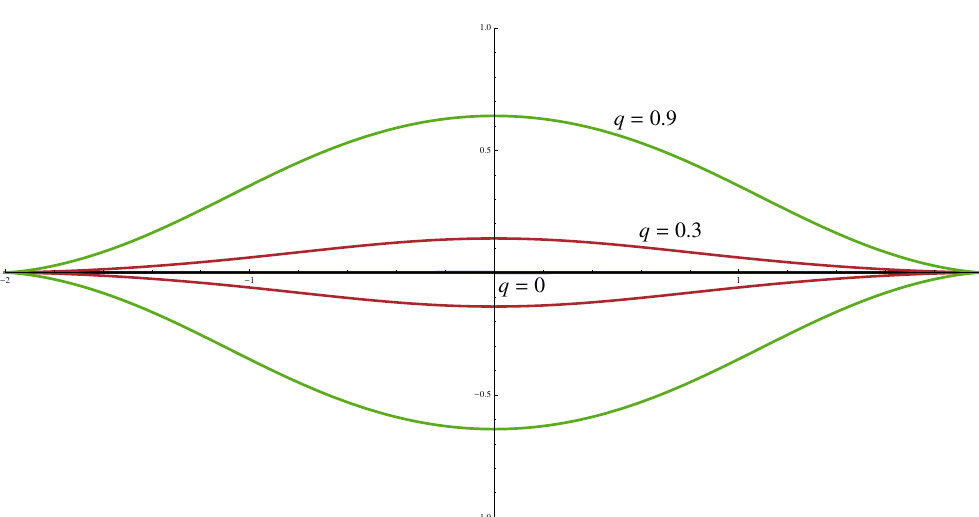
Figure 1 . The N = 2 i.e. \folded" version of the spiky string is plotted for di(cid:11)erent values of q . One must immediately note that for q > 0 the string does not pass through (cid:26) = 0 point, which is consistent with our computations. As q ! 1, the string gets more and more